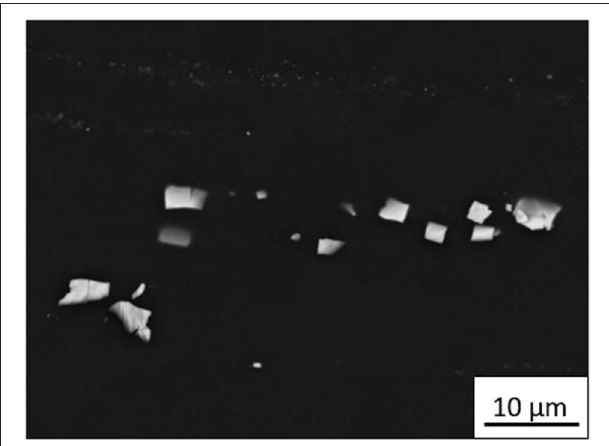
FIGURE 2 | SEM image (BSE) with GdH 2 particles aligned in extrusion